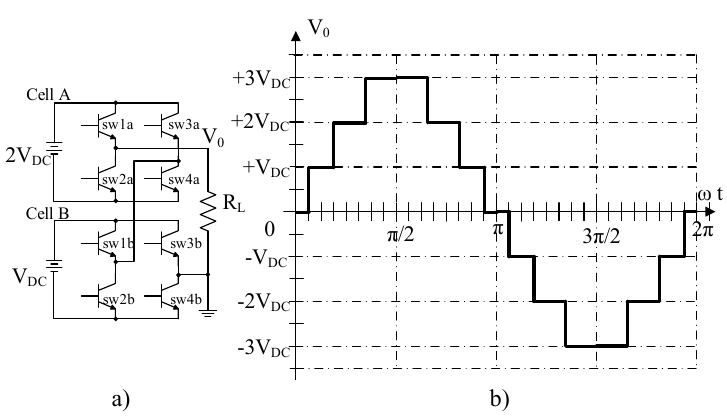
Figure 3. ( a ) Diagram of asymmetrical cascaded multilevel inverter with a seven-level, single-phase structure. ( b ) Output voltage waveform.